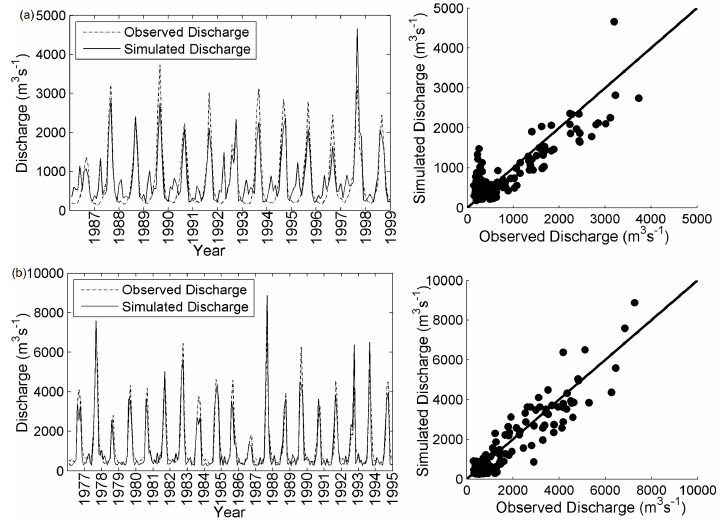
Figure 4. Calibration results of (a) upstream and (b) midstream regions.